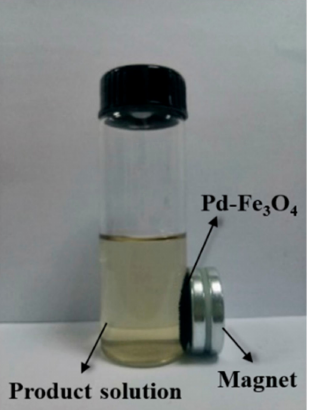
Figure 7. Separation of Pd-Fe 3 O 4 catalyst from reaction mixture by an external magnet.